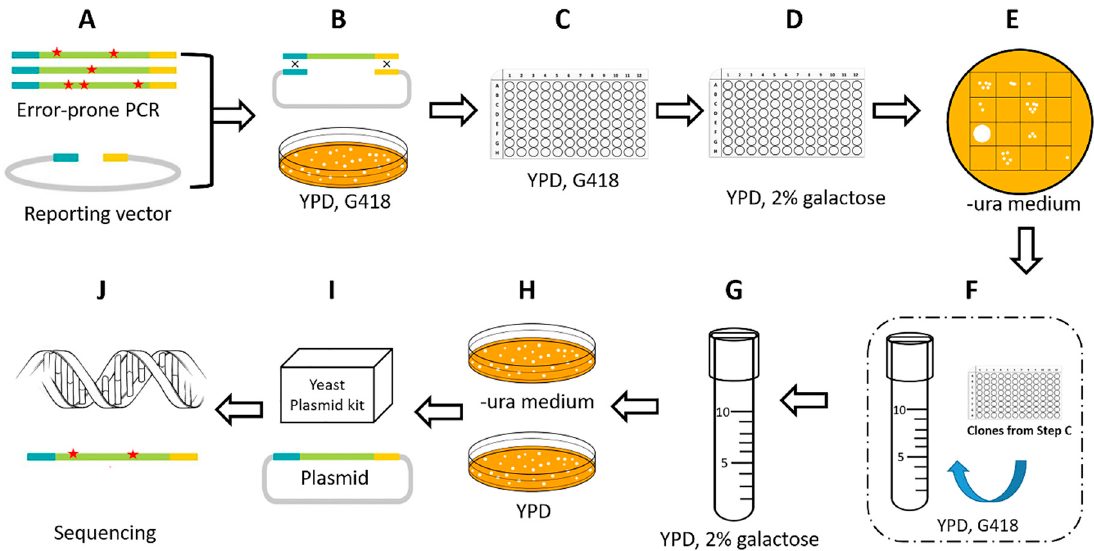
Figure 2. High-throughput screening process. ( A , B ) Generation of a mutant library of piggyBac transposase by error-prone PCR and a gap-repair system in yeast. ( C – E ) The first qualitative screening step. The mutants were grown and induced in a 96-well plates. After 24 h of galactose induction, the solution was diluted and spotted onto the uracil-deficient medium. Mutants that could reverse more clones were chosen for further quantitative analysis. ( F – H ) The second quantitative screening step. The mutants that were chosen from E and isolated from the C were grown and induced in 12 mL tubes. The concentration was adjusted to ensure a consistent growth condition. After 24 h of galactose induction, the solution was diluted and spread on the -ura medium plate and the YPD plate as control. The transposition efficiency was calculated and compared to the non-mutation one. ( I ) The isolated clones that exhibited high transpose activity were picked out and the plasmids were extracted. ( J ) The transposase fragment was sequenced for mutation site analysis.